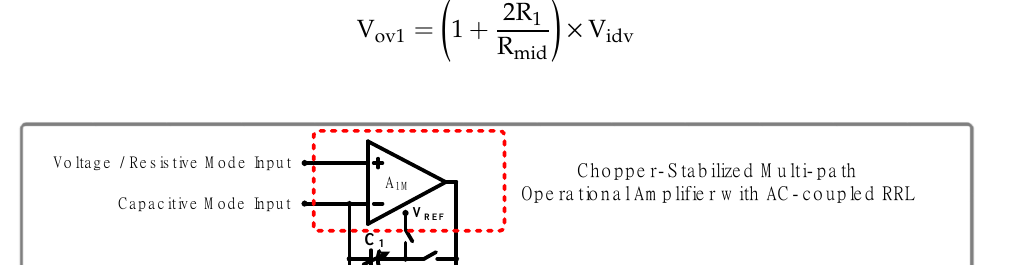
Figure 1. Block diagram of the proposed multimodal reconfigurable sensor readout circuit. ADC: analog-to-digital converter, LPF: low-pass filter.